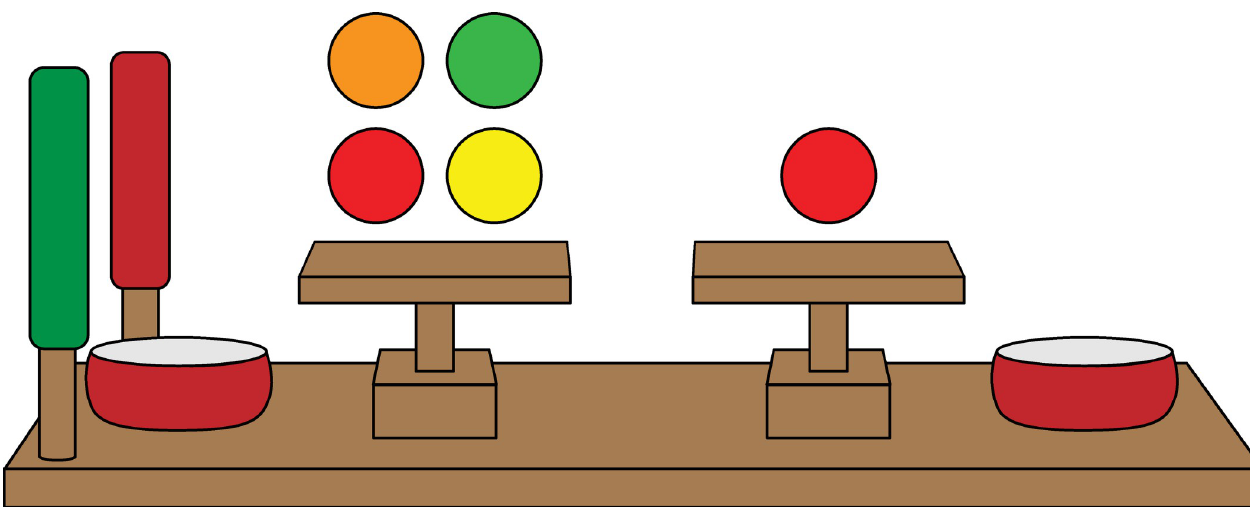
Fig 1. Diagram of apparatus used in the Inequity Game. Two people who do not know each other are asked to sit across from each other. The actor has access to the handles while the recipient sits passively across from the actor. The actor can accept (green handle) or reject (red handle) allocations that the experimenter places on the tilting trays. Acceptances cause rewards to be tipped into the side bowls while rejections cause rewards to be tiled into a middle bowl in which case neither participant gets them.